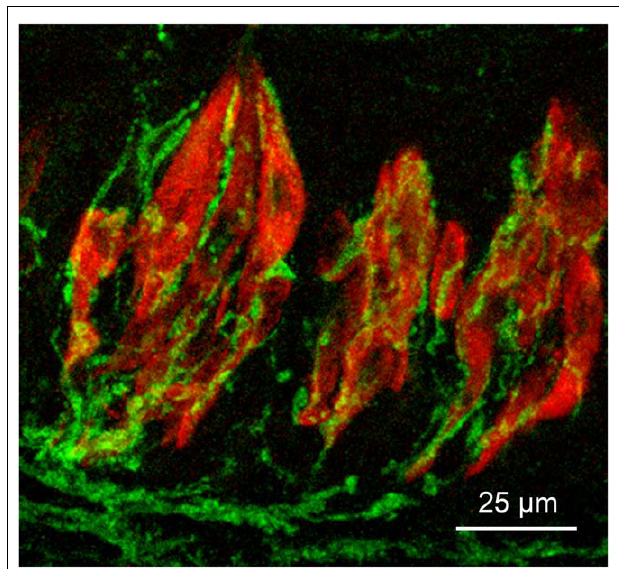
FIGURE 1 | Micrograph of longitudinal section through three taste buds in the circumvallate papilla of a mouse. Type II taste cells are stained red with antiserum to PLC β 2; gustatory afferent fibers are stained green with an antiserum to P2X3.The surface of the epithelium is at the top of the